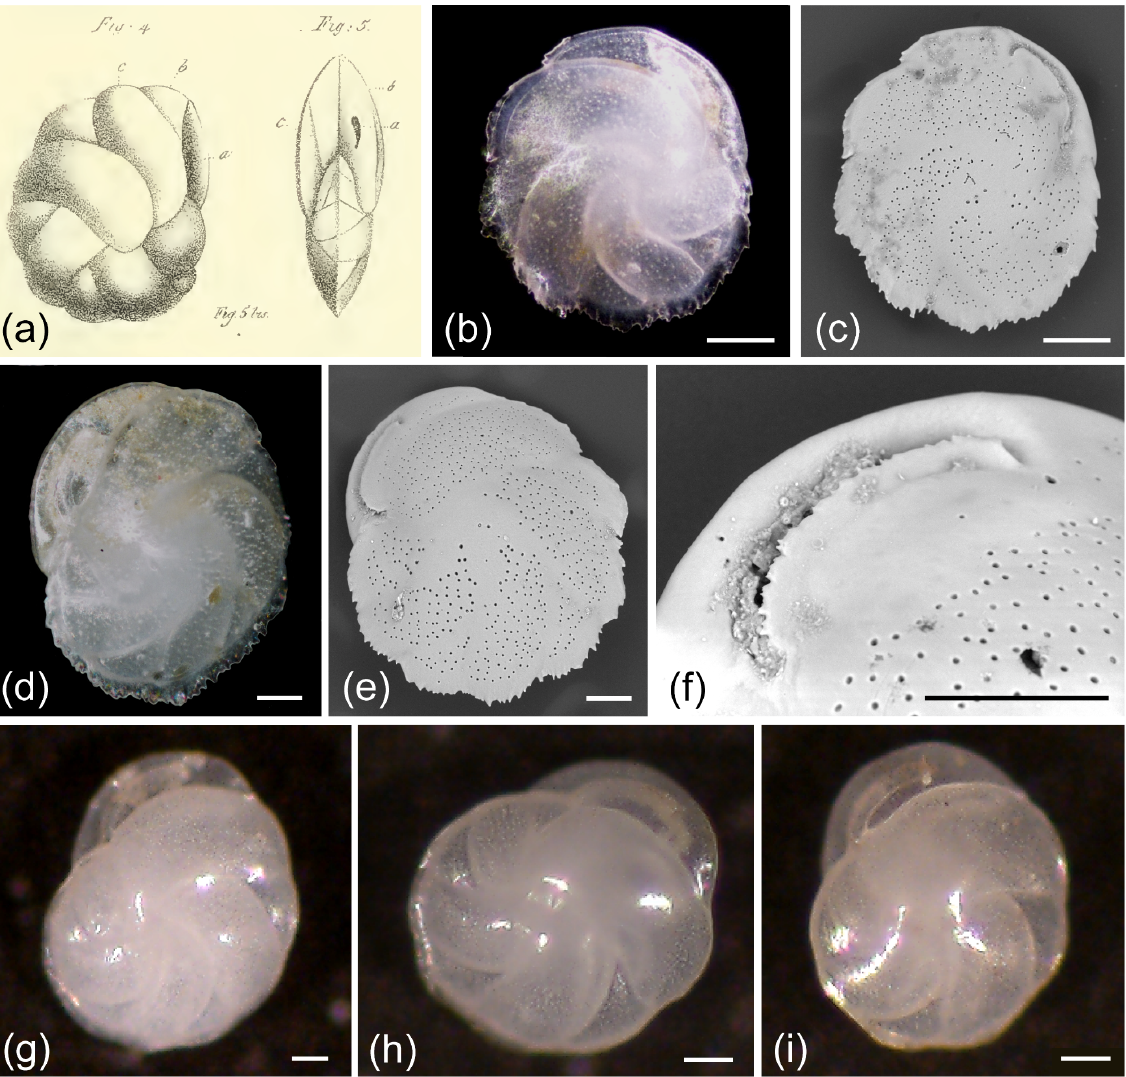
Figure 1. Cassidulina laevigata . (a) Original line drawing by d’Orbigny (1826) showing the species in (left) profile and (right) apertural view. Note that the small dot at the base between the two illustrations refers to the natural size of the specimen in the original publication, which does not provide sizes or size ranges for C. laevigata . (b–f) C. laevigata carinate forms. (g–i) C. laevigata without a carinated keel and showing a more rounded form. (b) Composite depth-of-field light microscope image and (c) SEM micrograph of the same specimen. (d) Composite depth-of-field light microscope image and (e) SEM image of the same specimen. (f) SEM micrograph of aperture showing the broad apertural lip and carinate margin on the plate. (g–i) Light microscope images of C. laevigata specimens that show a smoother outline compared to (b) – (e) . All scale bars denote 50µm; see Supplement Table S1 for sample